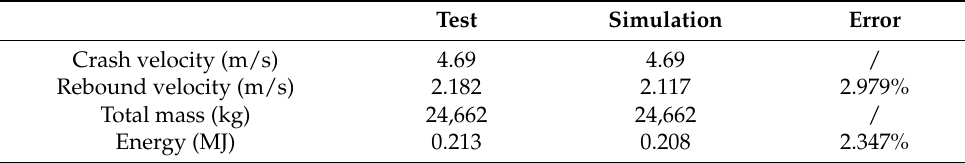
Table 2. Velocity and